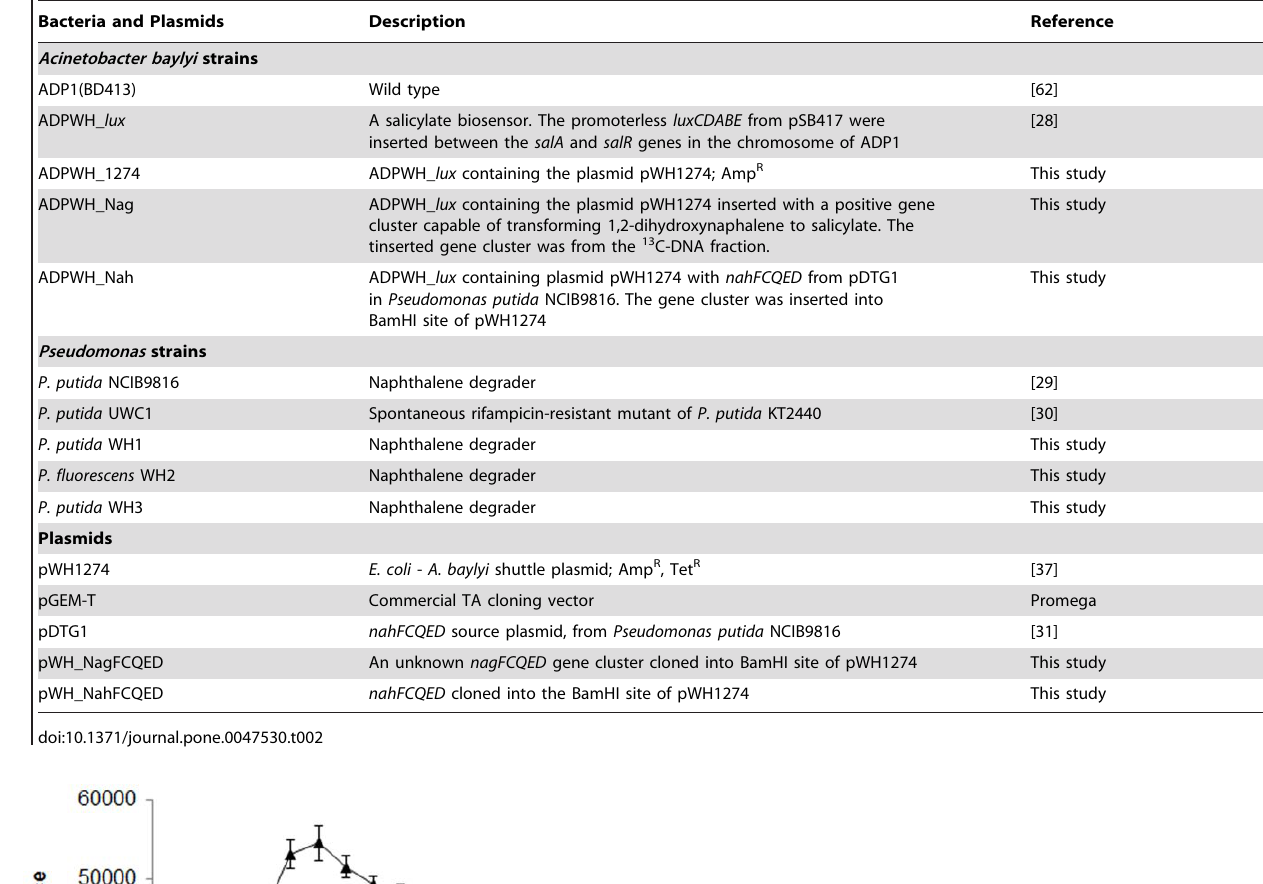
Bacteria and Plasmids